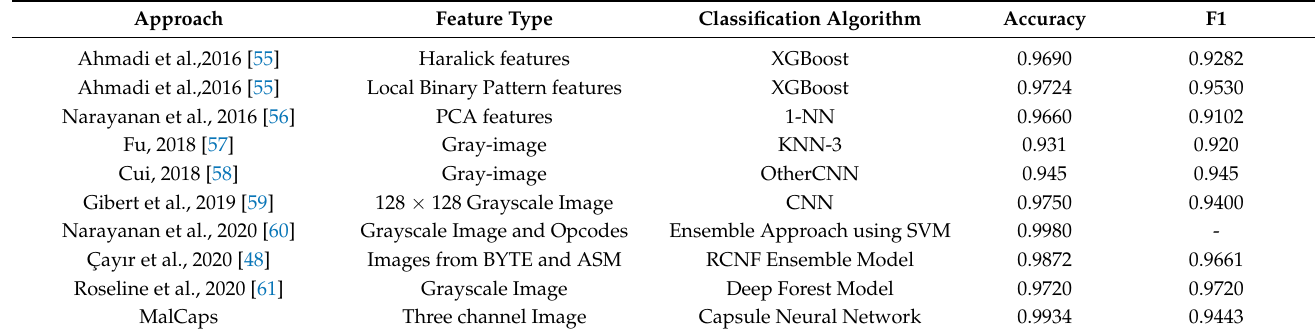
Table 5. Comparisons of different networks on the MMCC dataset depending on the feature of grayscale